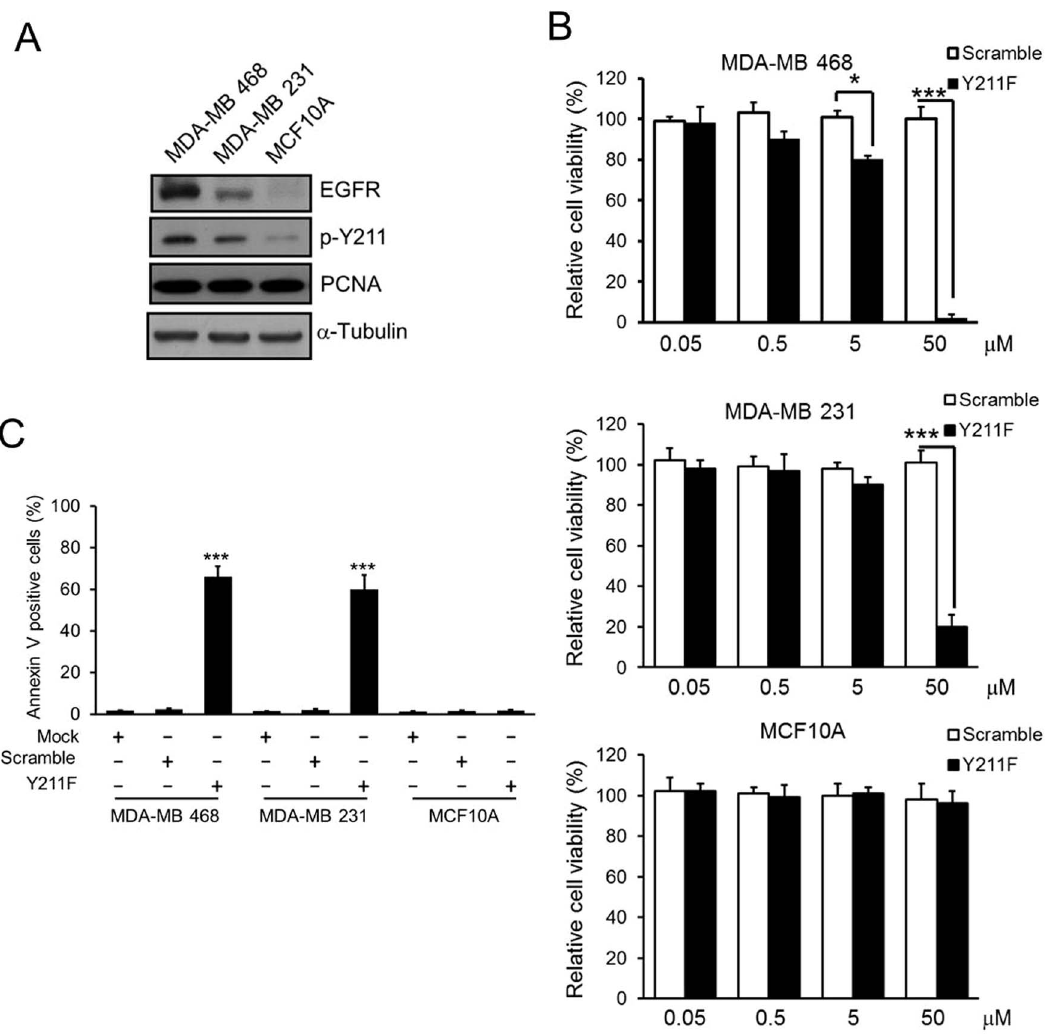
Figure 1. The phosphorylation of PCNA at Y211 and the cytotoxic effects of CPPP in normal breast cell line and TNBC cells. (A) Total cell lysate from MCF10A normal breast cell line or MDA-MB 468 and MDA-MB 231 TNBC cell lines were extracted, the protein levels of EGFR and total PCNA were determined by immunoblotting (IB). The Y211 phosphorylation of PCNA was examined by immunoprecipitation (IP) with anti-p-Y211 antibody and followed by IB against PCNA. (B) Each TNBC cell line was treated with indicated concentration of scrambled (Scramble) or Y211 CPPP (Y211F) peptides for 24 h. The relative cell viability was measured by WST-1 assay. (C) The percentage of the apoptotic cells from each TNBC cell line after 24 h treatment with 15 m M of Mock (PBS), Scramble and Y211F were determined by flow cytometry of Annexin V-positive cells. The bars indicate mean 6 S.D. *, p , 0.05; ***, p , 0.001 by t -test.